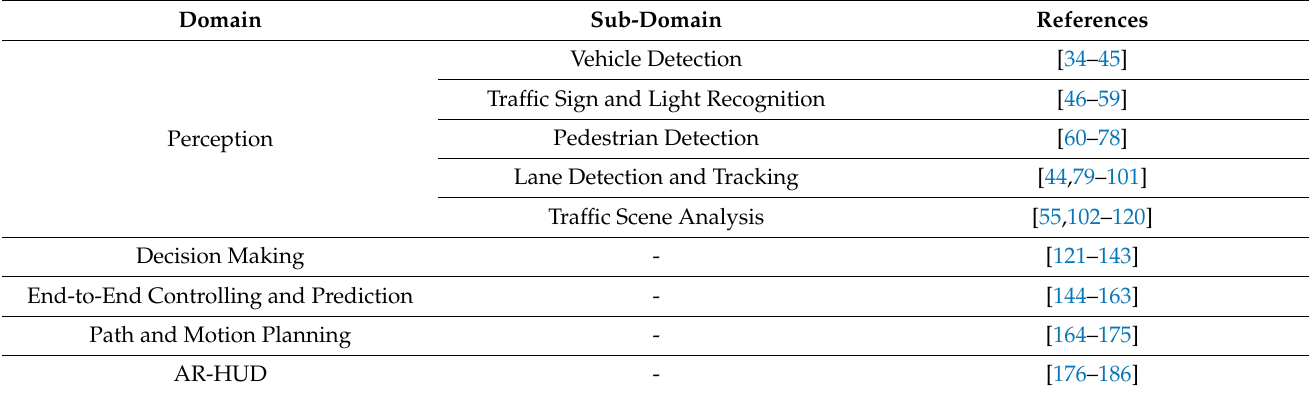
Table 4. Literature taxonomy of AVS using deep learning approaches.